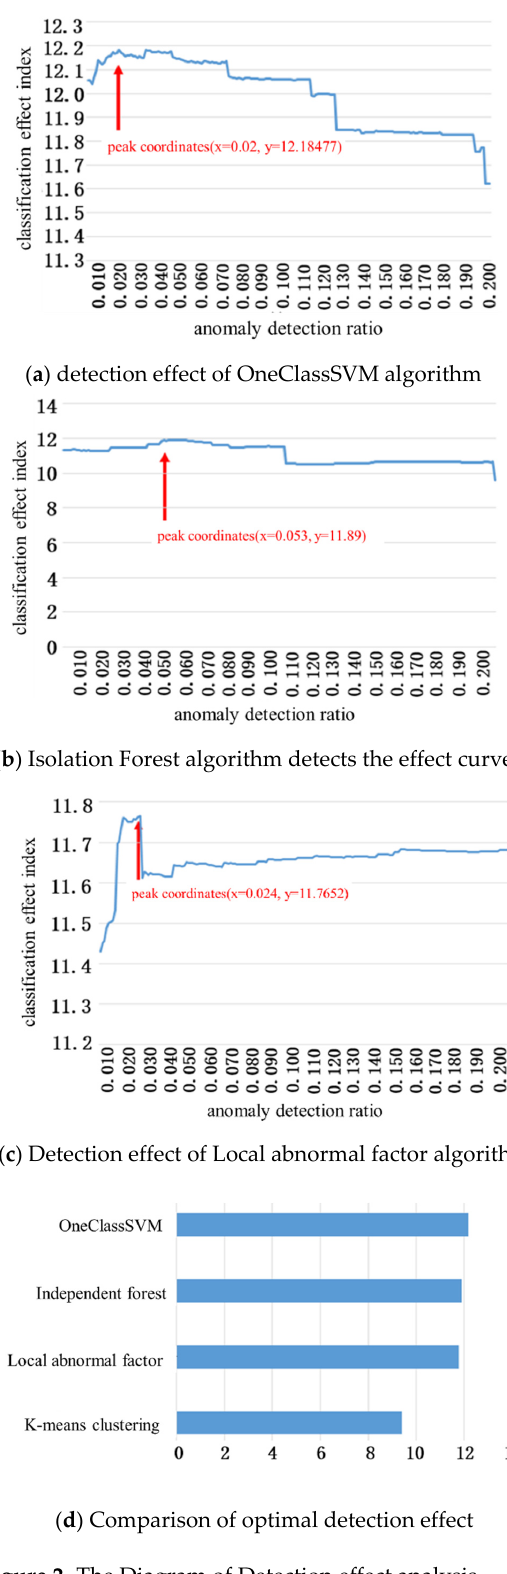
Figure 2. The Diagram of Detection effect analysis.